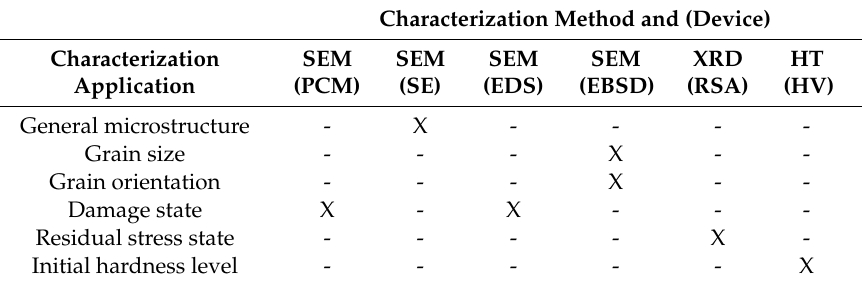
Figure 2. ( a ) Surface profile of the specimens; indicating a exemplary depth of initial damage ( D i ) of up to 2 µm; ( b ) Forming-induced initial damage ( D i ) at the specimen surface after manufacturing. Table 2. Characterization methods and application